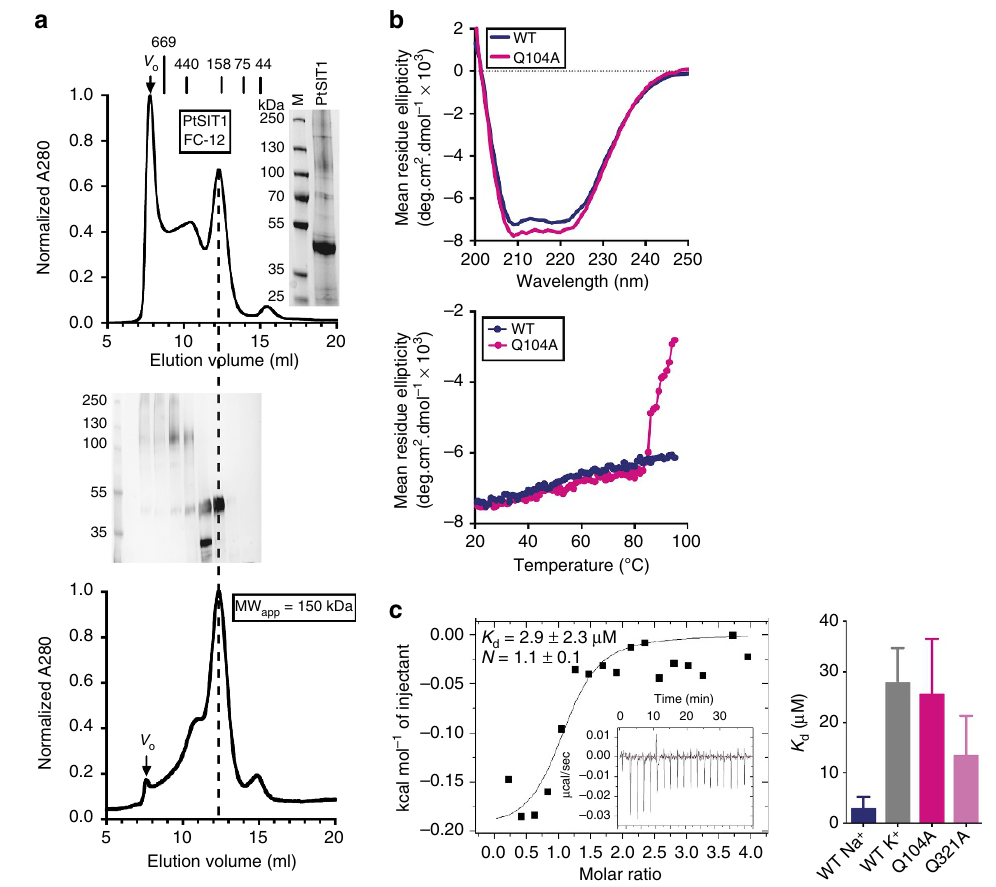
Figure 2 | Characterization of PtSIT1. ( a ) PtSIT1 purified in FC-12 is heterogeneous during size-exclusion chromatography but a sharp peak does elute at 12.3ml. V o , void volume. Inset, Coomassie-stained SDS–PAGE gel of loaded PtSIT1. Column fractions were analysed by SDS–PAGE with AgNO 3 staining. The 12–13ml fraction remains a single peak when reapplied to the column, and elutes at a volume equivalent to 150kDa relative to molecular-weight standards as shown. ( b ) Circular dichroism spectroscopy confirms the a -helical secondary structure of PtSIT1 and a representative mutant, Q104A, and the sensitivity of these proteins to temperature. ( c ) Isothermal titration calorimetry of PtSIT1 and selected glutamine mutants. Values are derived from curve fitting to a one-site equation ± s.e.m for a single